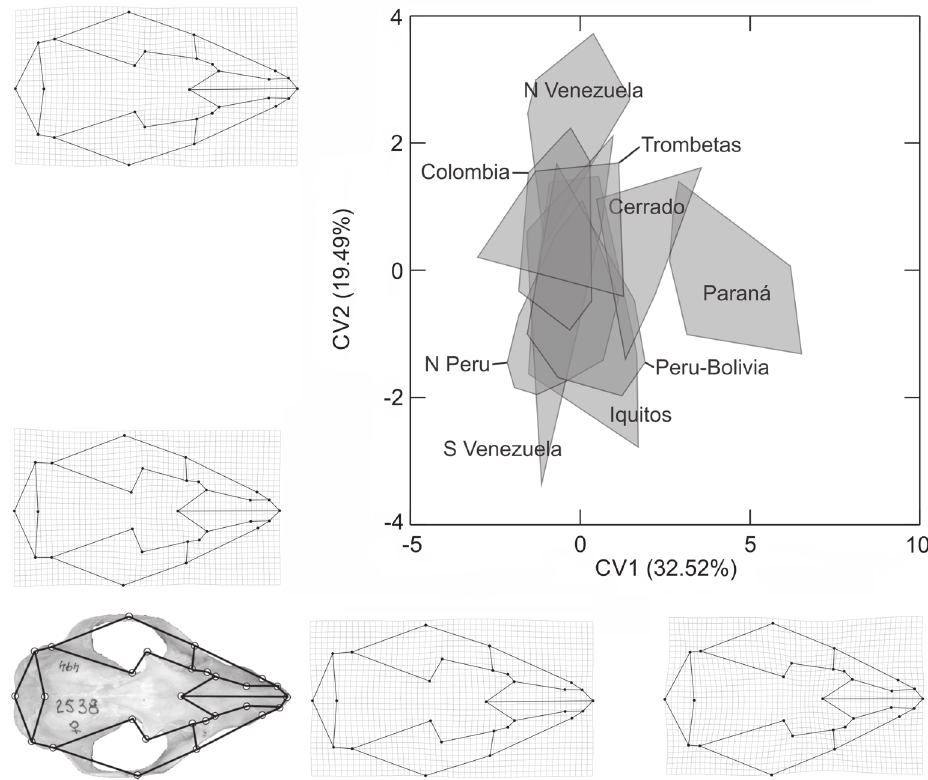
Figure 6. Canonical Variates Analysis on shape variables (partial warps and uniform components) of the cranium in dorsal view of Caluromys lanatus , using localities as grouping factors, and percentage of variance explained by the first two CVs. Only the convex hulls for each population are shown. Grids indicate deformation associated with the extremes of each CV, from a multivariate regression of shape variables onto CV